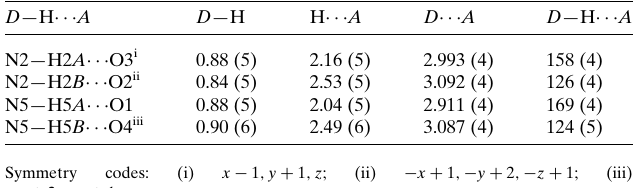
Table 2 Experimental details.